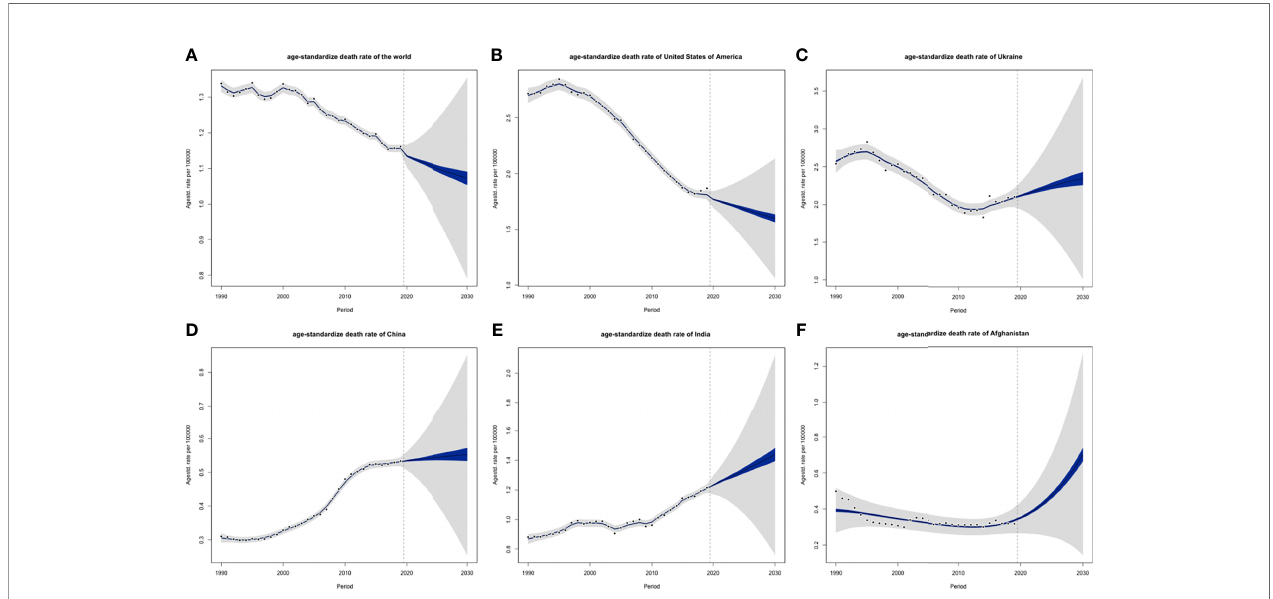
FIGURE 14 | Projections of ASDRs of (A) the world, (B) USA, (C) Ukraine, (D) China, (E) India and (F) Afghanistan from 2020 to 2030: blue areas are 5% con fi dence intervals and grey areas are 95% con fi dence intervals; black dots are observation value from 1990 to 2019 (ASDR, age-standardized death rate;